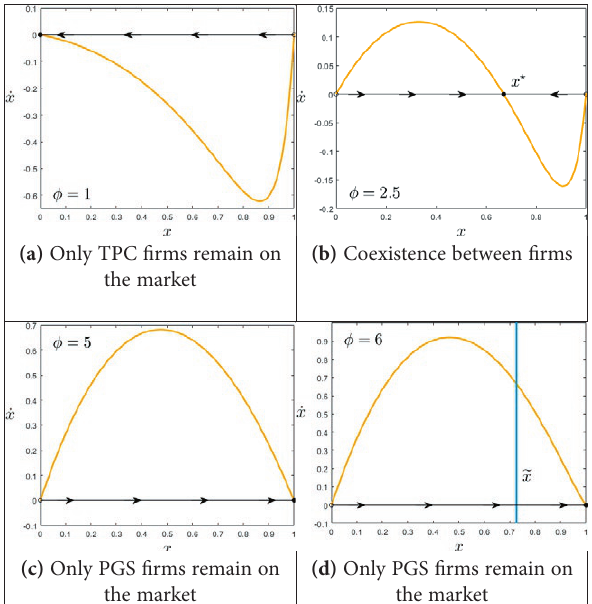
Figure 3. Dynamic regimes. Parameter values: α =0.95, =10, e g =5, e c =5, n =5. Legend: • sinks, ⚬